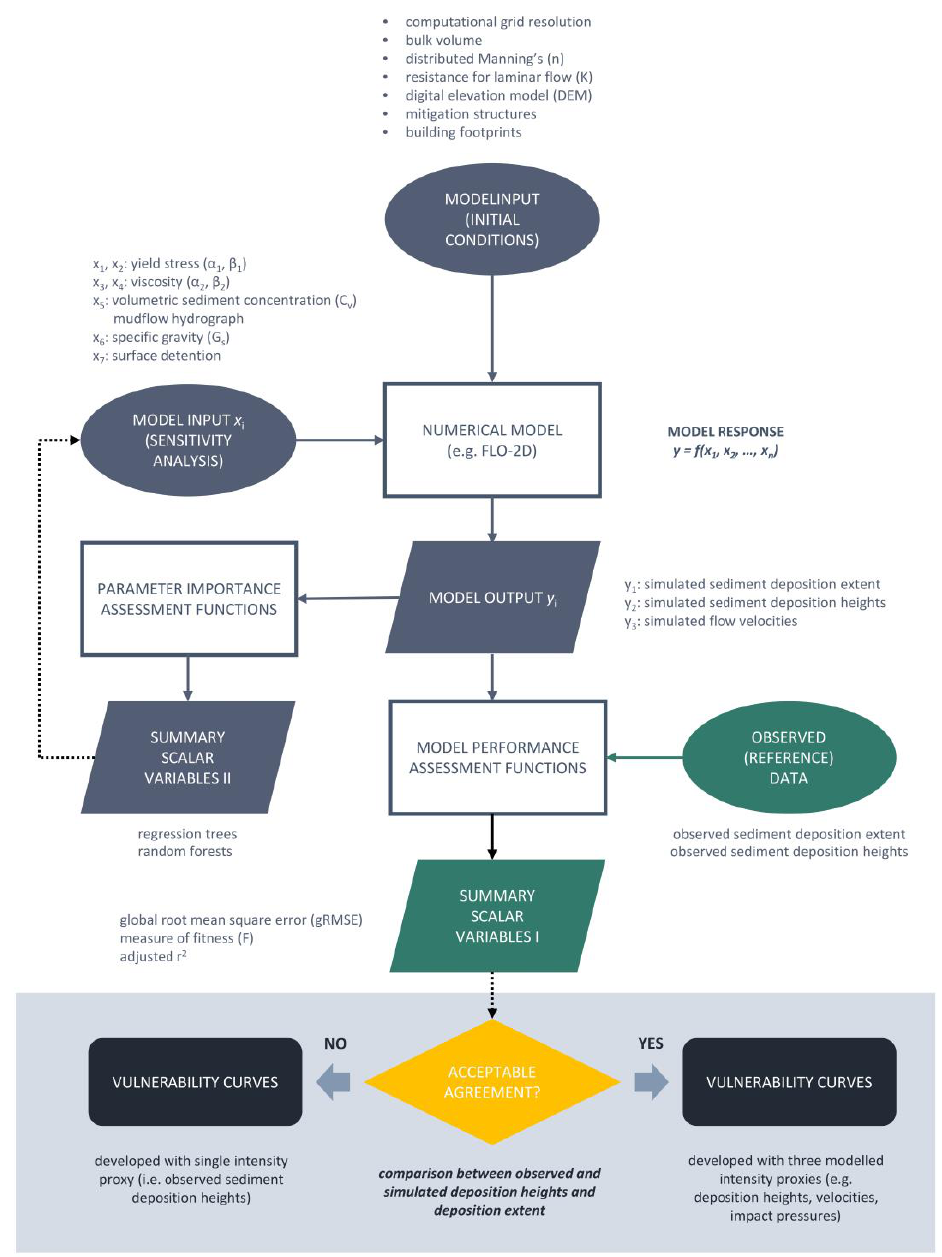
Figure 2. Schematic illustrating how the different sources of data are fed into the dynamic numerical model to generate simulated outputs; summary scalar variables are subsequently produced to support model performance evaluations and provide insight about the potential use of simulated intensity proxies to further develop physical vulnerability curves.